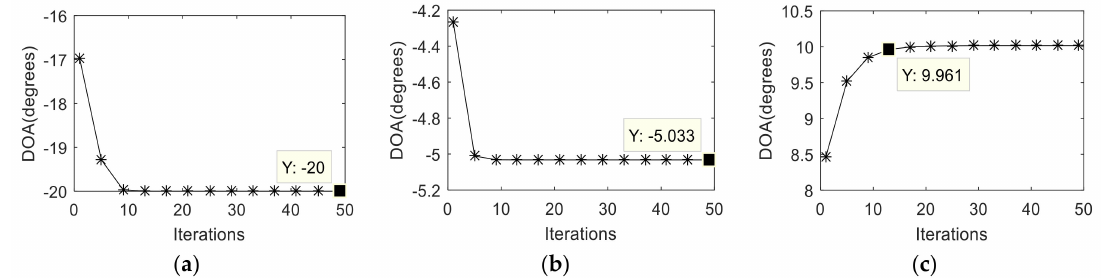
Figure 4. Variation of the estimated DOAs versus the iterations of three signals. ( a ) Variation of the estimated DOAs versus the iterations of signal 1; ( b ) Variation of the estimated DOAs versus the iterations of signal 2;( c ) Variation of the estimated DOAs versus the iterations of signal 3.